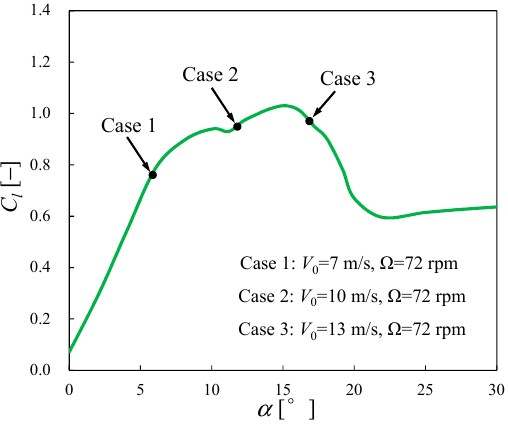
Figure 5. Operating points of the cross-section of r / R = 0.63 on the lift polar of the S809 airfoil. (The Reynolds number of the airfoil is 1 × 10 6 which is close to that of the cross-section). The normal and tangential forces along a blade of the NREL 5MW rotor are plotted in Figure 6.